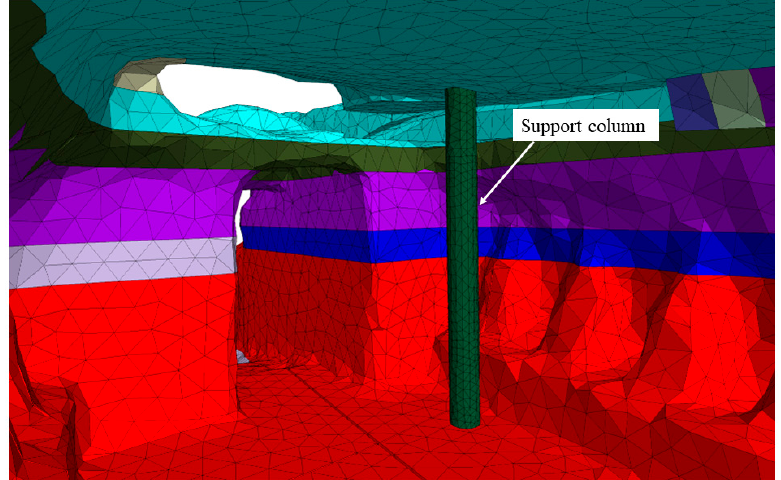
Figure 19. Three-dimensional geological model of Yuanjue Cave with a support column